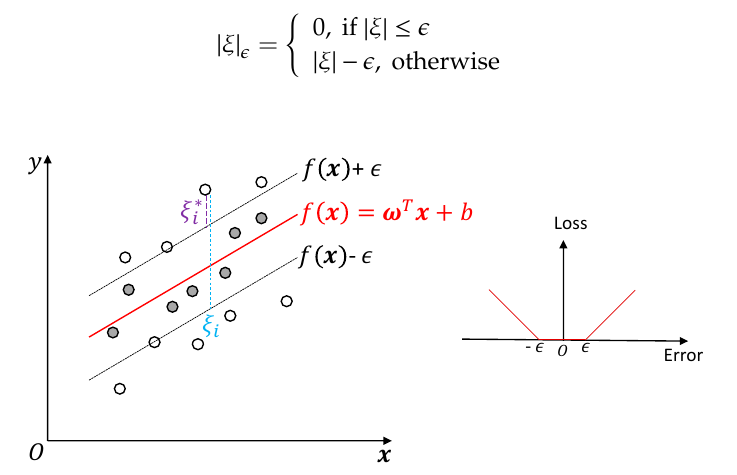
Figure 4. Sketch diagram for the support vector regression (SVR) method.